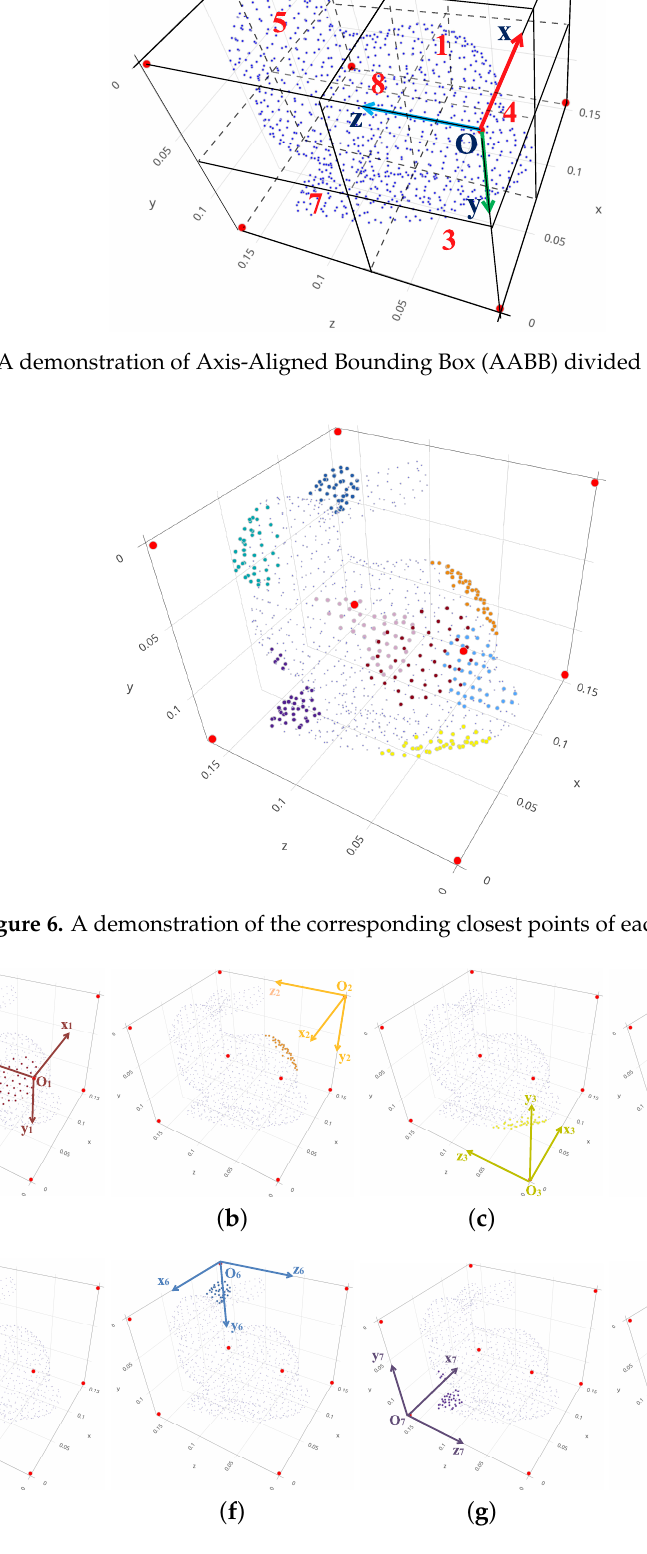
Figure 7. The corresponding closest points according to each corner: ( a ) Corner 1, ( b ) Corner 2, ( c ) Corner 3, ( d ) Corner 4, ( e ) Corner 5, ( f ) Corner 6, ( g ) Corner 7, ( h ) Corner